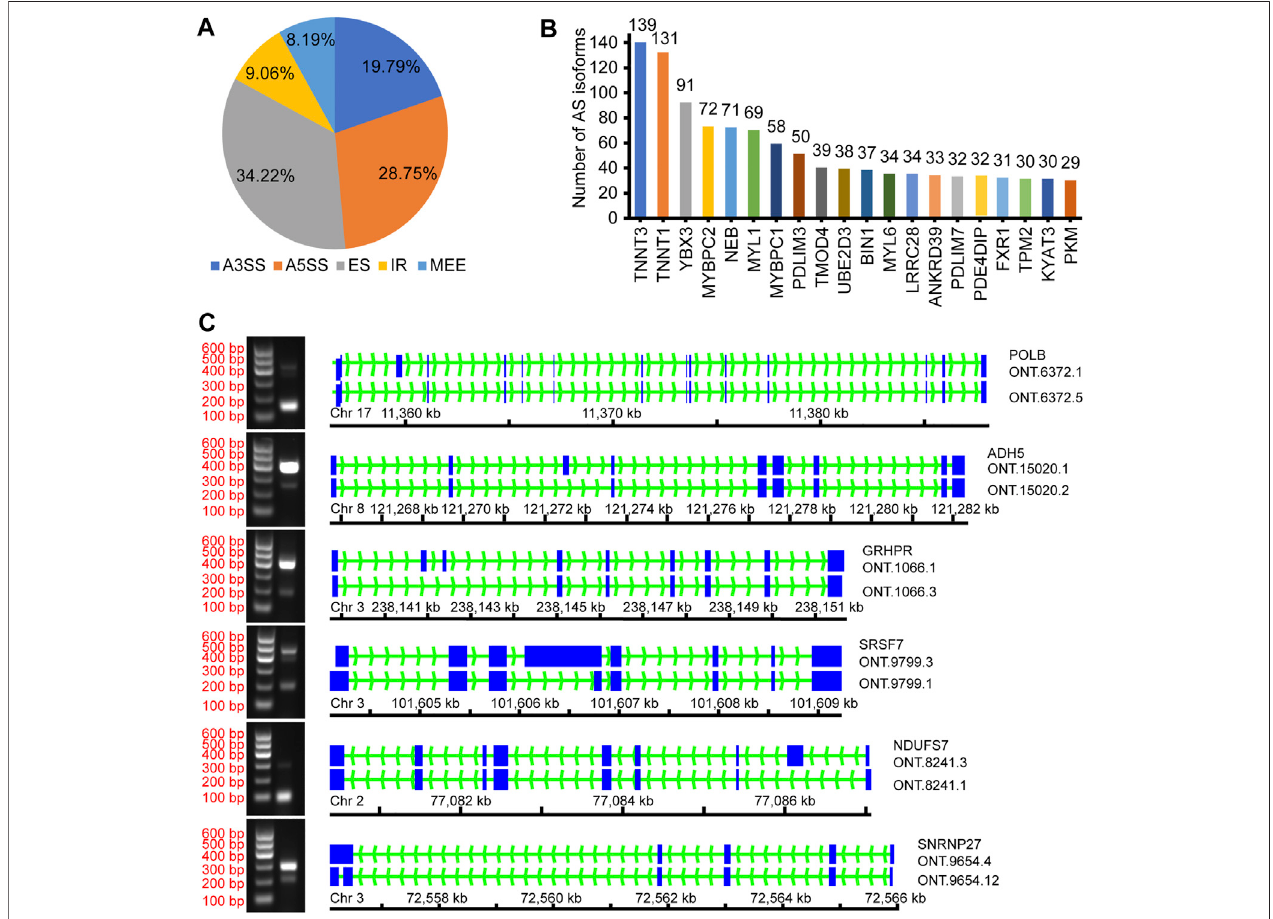
FIGURE 2 | Overview of alternative splicing. (A) The proportion of different AS events; (B) The number of different gene splicing isoforms; (C) Verify different AS events.